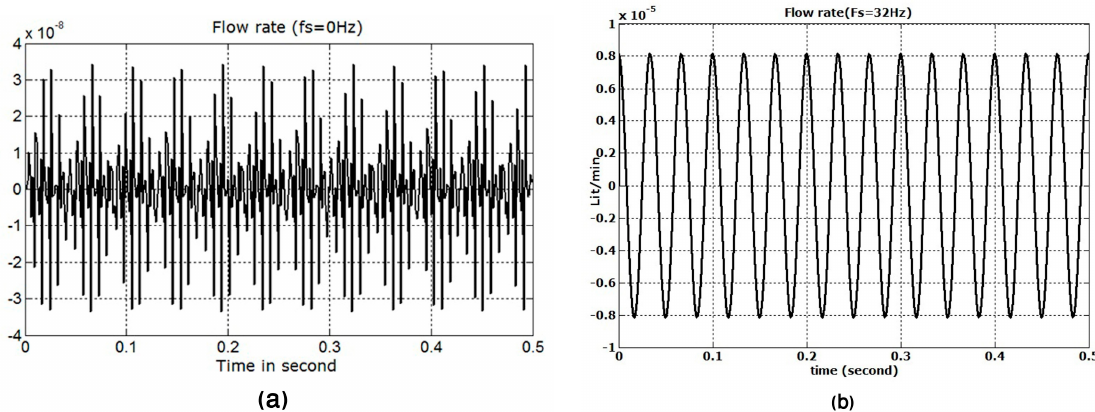
Figure 11. ( a ) Flow rate obtained at ~0 μ L/min with dynamic behavior and fs = 0 Hz. ( b ) Flow rate obtained at ~8 μ L/min (half die) with dynamic behavior and fs = 32